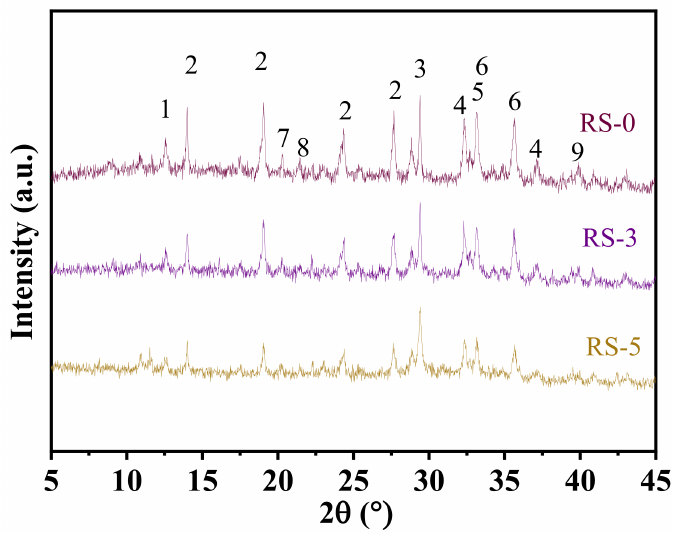
Figure 7. XRD patterns of composite cementitious material at 28 days with different slag contents